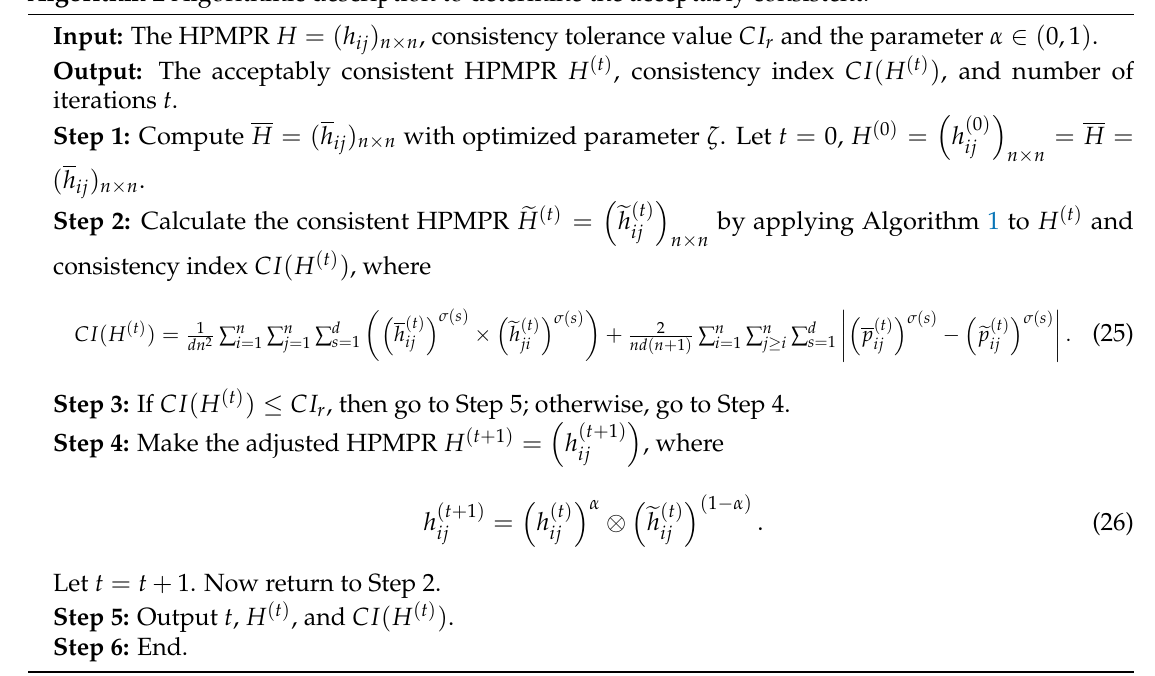
Algorithm 2 Algorithmic description to determine the acceptably